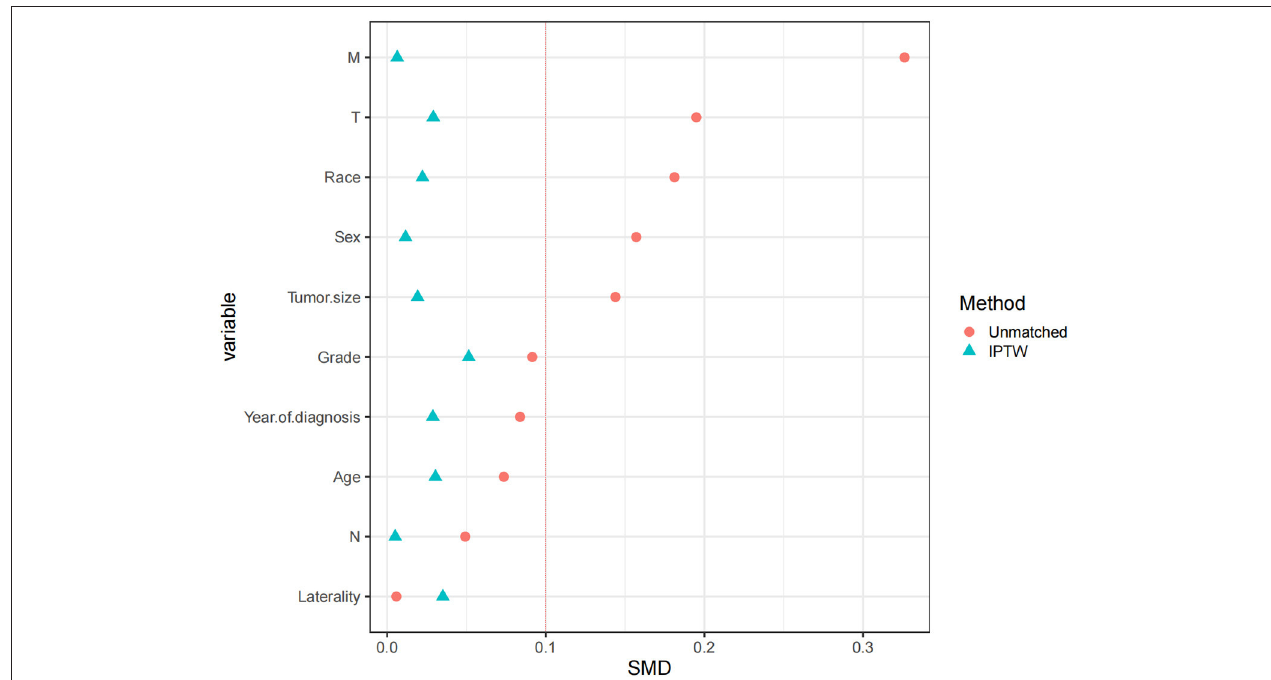
FIGURE 5 | Standardized mean difference distribution of patients after the inverse probability of treatment weighting matching.